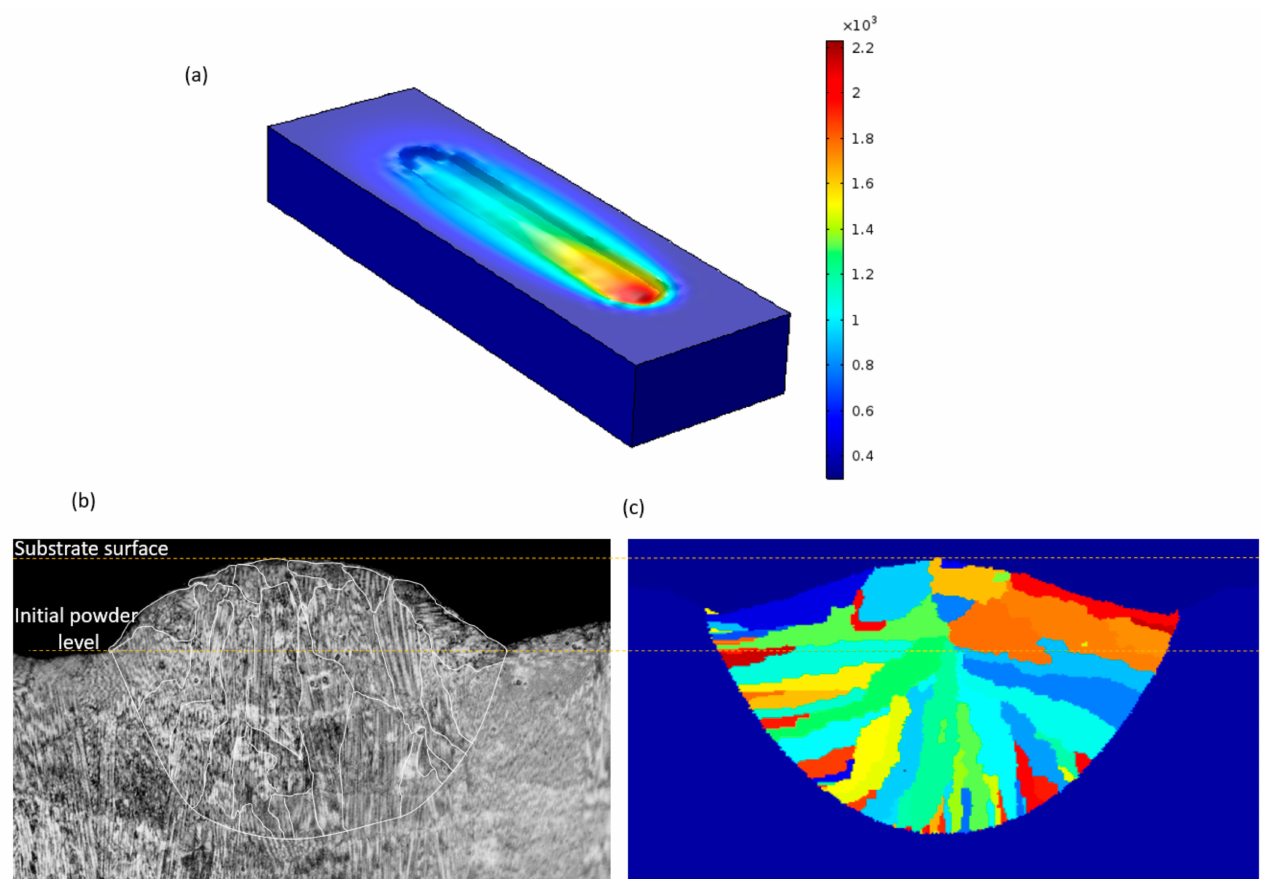
Figure 1. Temperature distribution and track morphology, ( a ) 3D temperature distribution of single track fabricated at laser power 250 W and scanning speed 700 mm/s, ( b ) experimental OM image of cross-section of single track morphology, and ( c ) simulation results for a cross-section of single track morphology; the grain boundaries of experimental results are indicated by a white